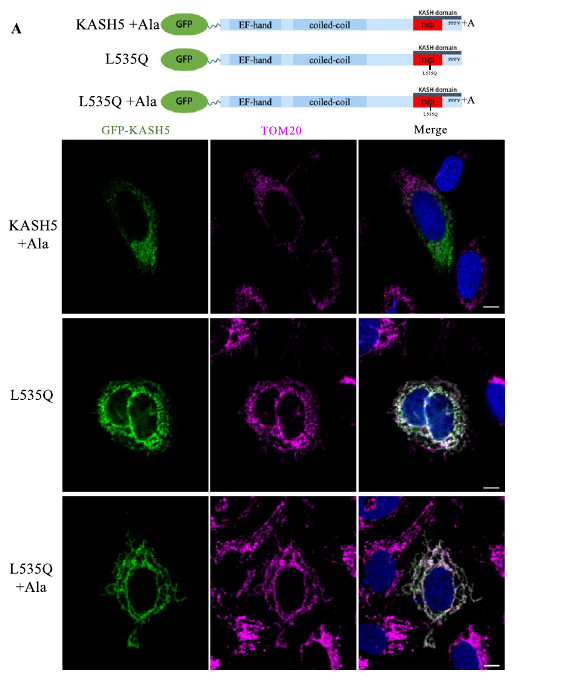
Figure 6. Addition of alanine to the KASH domain does not disrupt L535Q mitochondrial targeting. ( A ) U2OS cells grown on coverslips were transfected with an N-terminal GFP-tagged version of wild-type +Ala, L535Q or L535Q + Ala KASH5. Mitochondria localization was assessed with an anti-TOM20 antibody (pink). ( B ) Pearson’s correlation coefficient between GFP-KASH5 and TOM20 N = 58. The experiment was repeated four